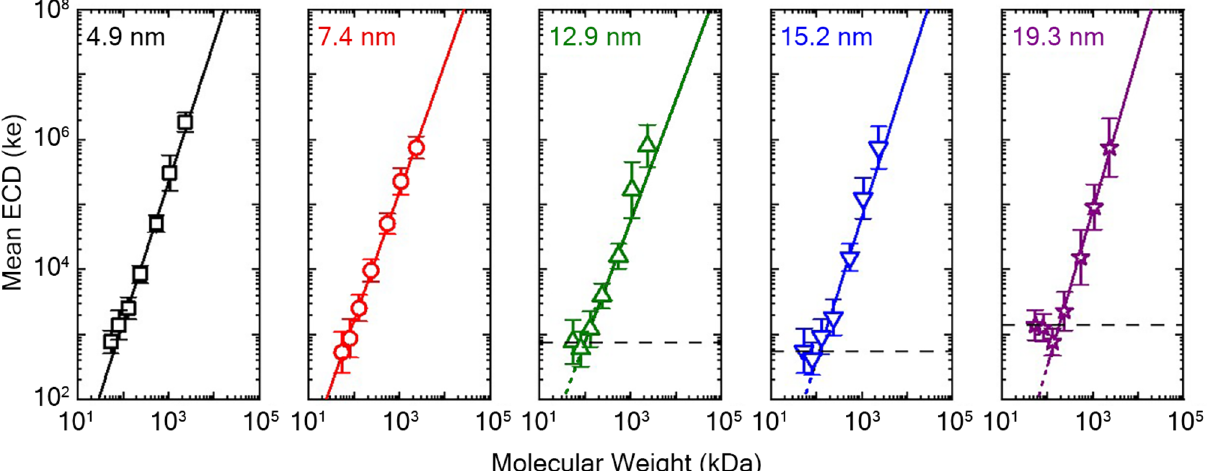
Figure 4. Mean ECD vs. quasi-monodisperse MW for SS-nanopores of various diameter [left to right: 4.9 (black squares), 7.4 (red circles), 12.9 (green triangles), 15.2 (blue inverted triangles), 19.3 nm (purple stars)]. Solid lines are power law fits (of the form y = b + x α ) to the data down to the apparent noise floor (dashed line). A comparison of the fit exponent α across conditions is shown in Supplementary Fig. S7b (inset).